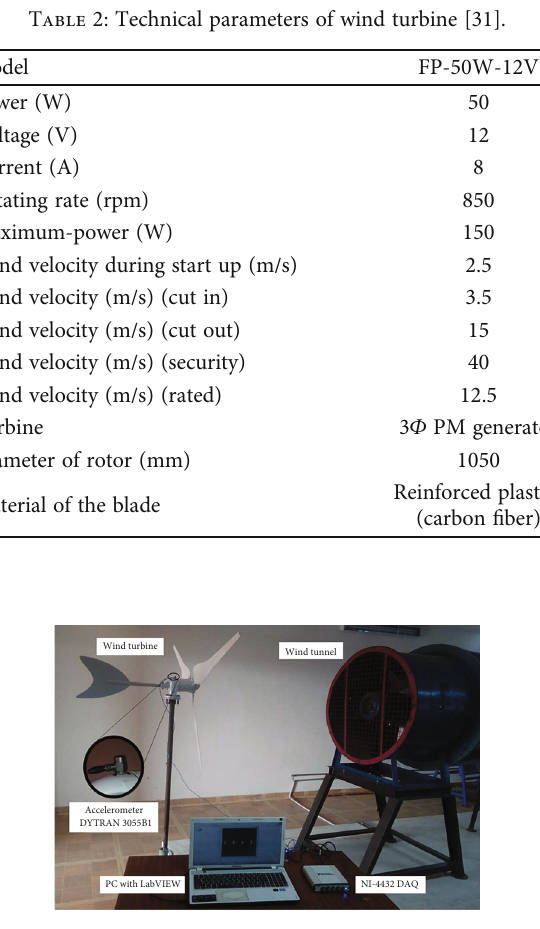
Figure 2: Experimental